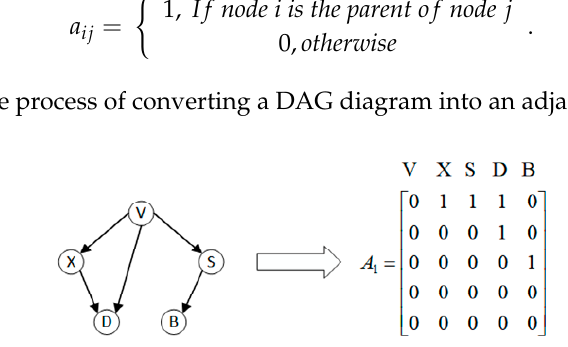
Figure 2. Directed acyclic graph (DAG) diagram is transformed into adjacent matrix.